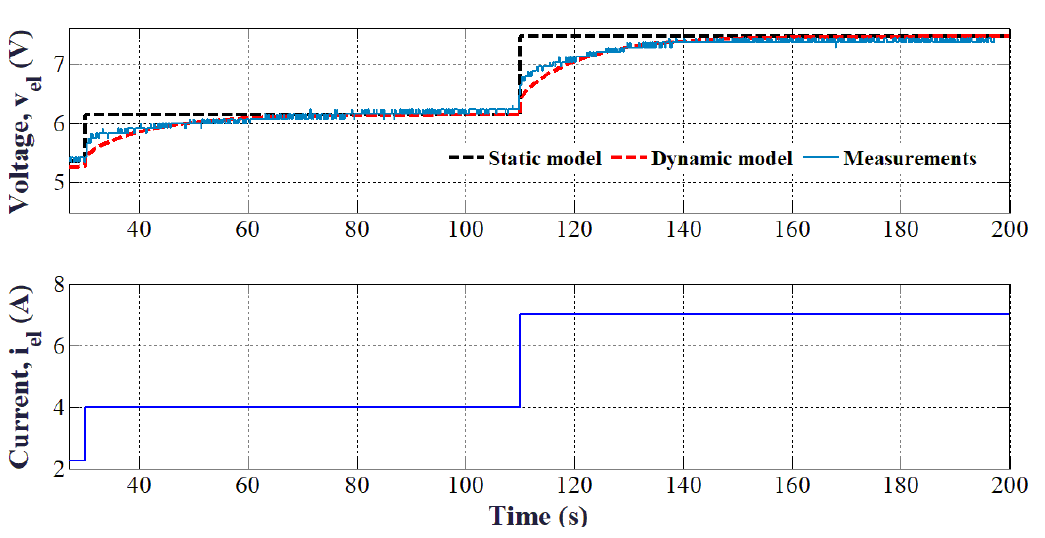
Figure 20. Comparison of the voltage response between a static and a dynamic model [24].